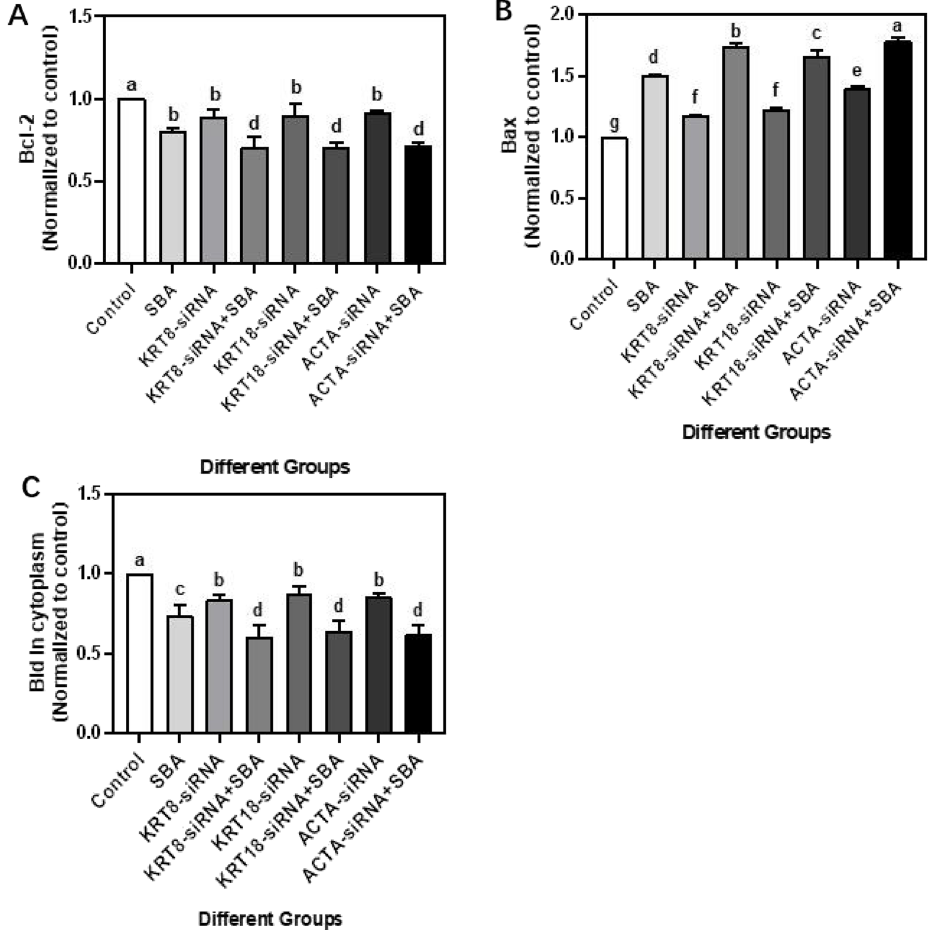
Figure 22. ( A – C ). Analysis of protein expression of Bid, Bcl-2 and Bax in different treatment groups. The protein expressions in different treatments were obtained from the western blot represented. ( A ) The protein expression of cytosolic Bid; ( B ) The protein expression of Bcl-2; and ( C ) The protein expression of Bax. Data were analyzed using Bandscan software. Each column represents the mean ± SEM of three independent experiments. Different lowercase letters indicate the significance of differences between different treatment groups ( p <